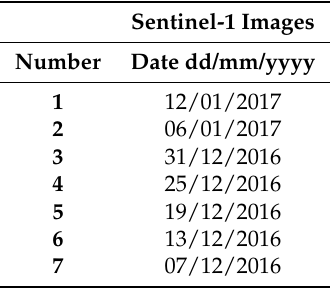
Table 1. List of the Sentinel-1 images used in this